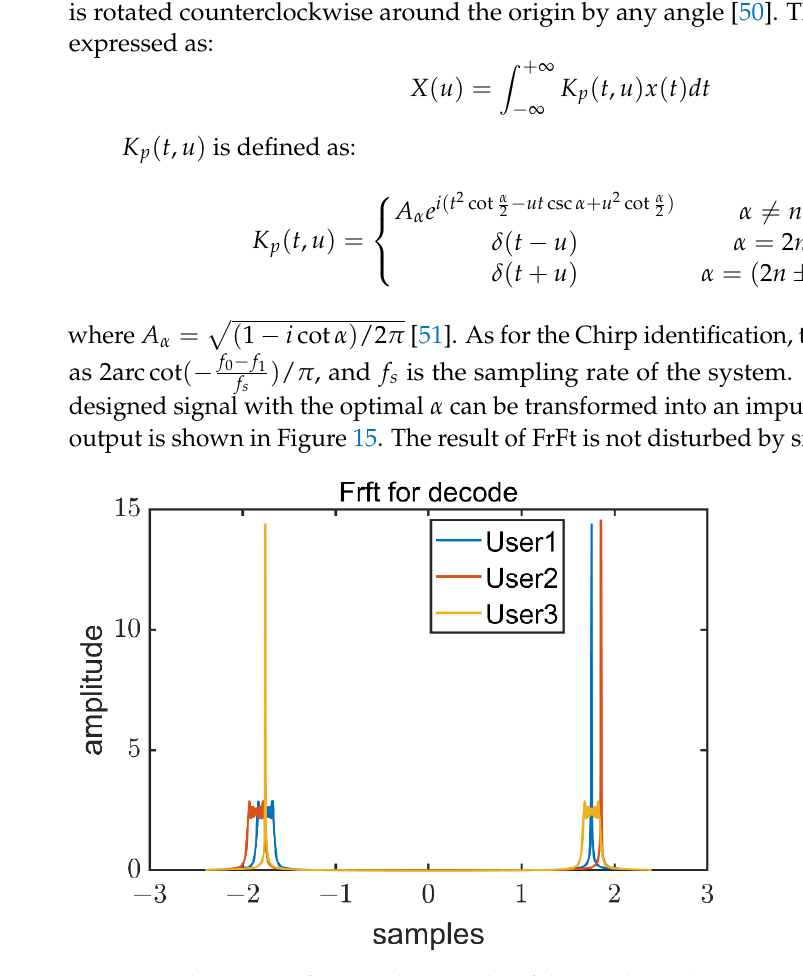
Figure 15. The output of FrFt with optimal α of designed